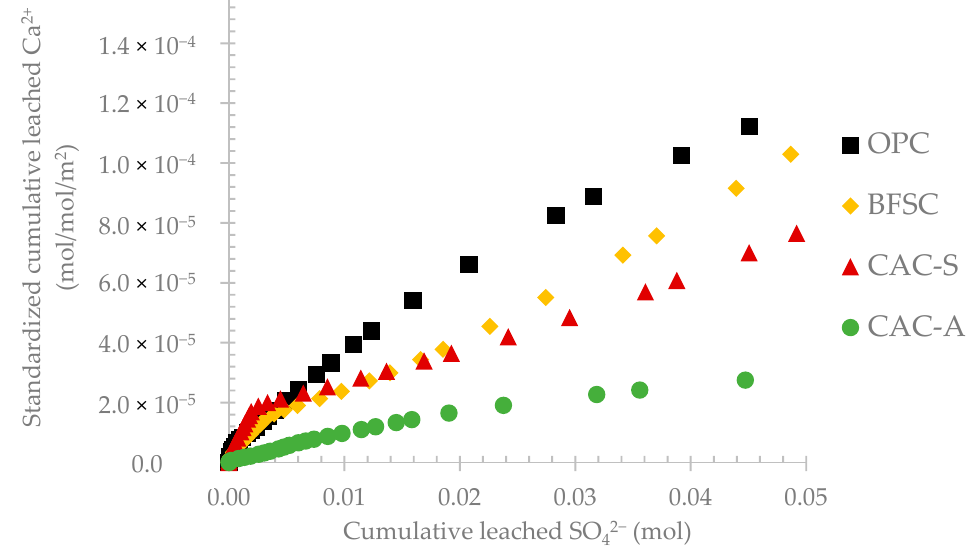
Figure 6. Evolution of the standardized leached calcium as a function of the leached sulfate during the exposure period.